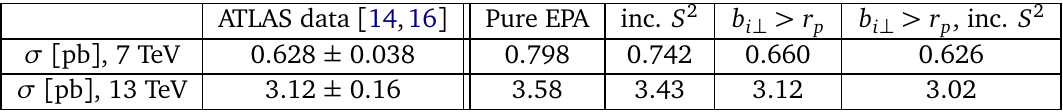
Table 2: Comparison of predictions for exclusive dimuon production in pp collisions, (cid:112) s = 7 and 13 TeV, within the fiducial acceptance. with the ATLAS data [ 14, 16 ] at The data uncertainties correspond to the sum in quadrature of the statistical and